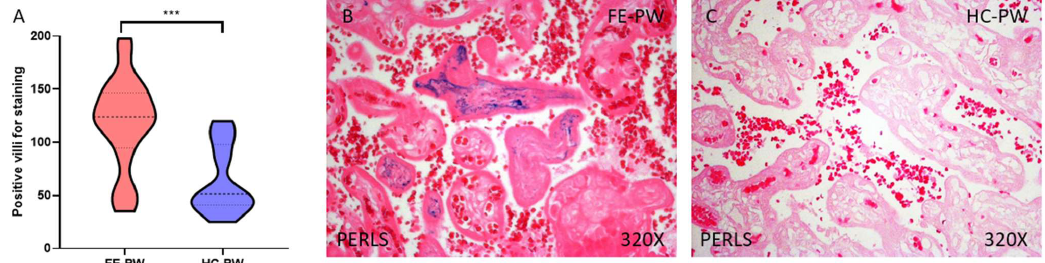
Figure 1. Histopathological study of iron deposits using the Perls’/Prussian Blue staining for positive villi ( A ), in the FE-PW ( B ), and HC-PW ( C ) group. FE-PW = first psychotic episode during pregnancy. HC-PW = healthy controls pregnant women. p < 0.001 (***).